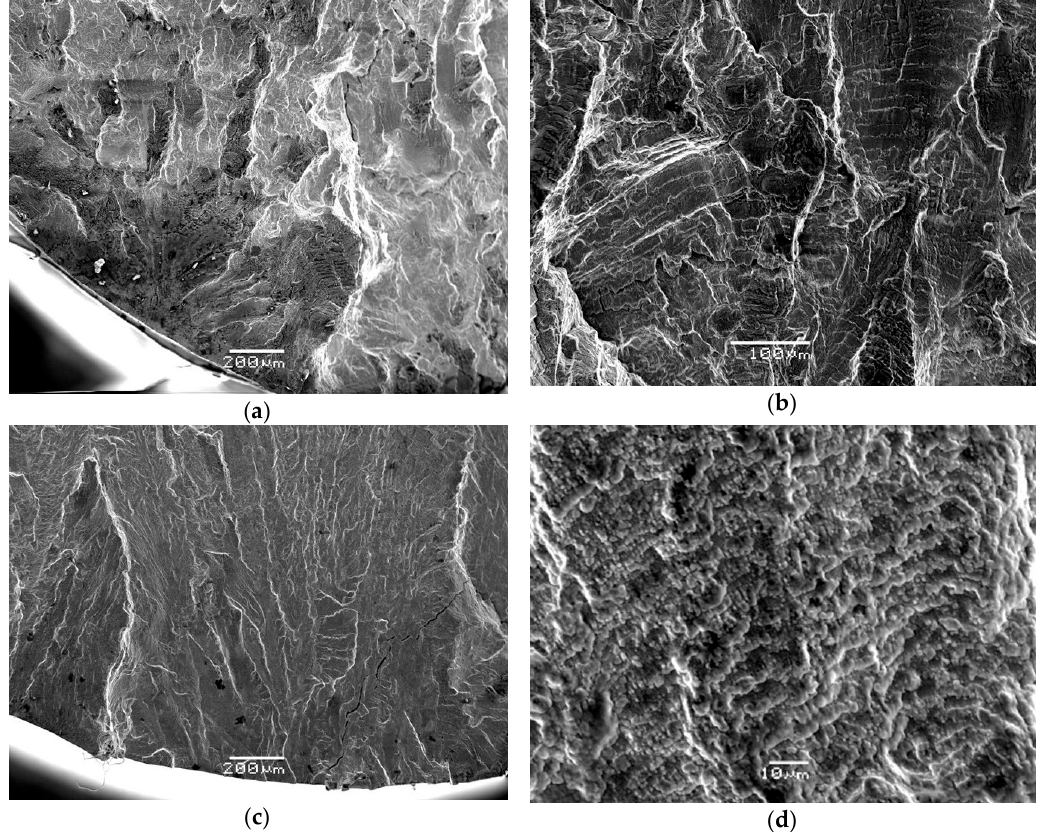
Figure 13. Typical scanning electron microscope (SEM) images for LCF crack initiation and propagation tested at 0.6% total strain range: ( a ) crack initiation, BM; ( b ) crack propagation, BM; ( c ) crack initiation, weldments; and ( d ) crack propagation, weldments.